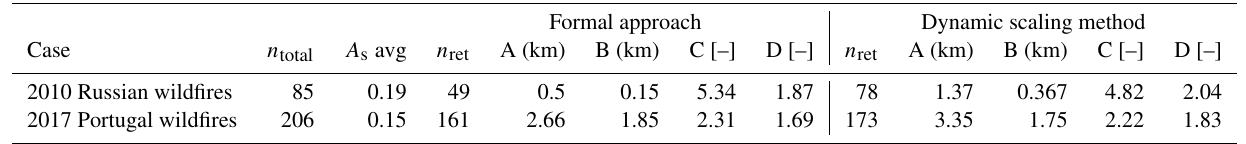
Table 5. Retrieval results from GOME-2 experiments. Columns marked with A, B, C and D are mean retrieved z aer (km), SD of retrieved z aer (km), mean fitted τ and SD of the fitted τ , respectively. n total represents the total number of pixels in the scene, and n ret represents the number of retrieved pixels. A s avg represents the average surface albedo of the scene.